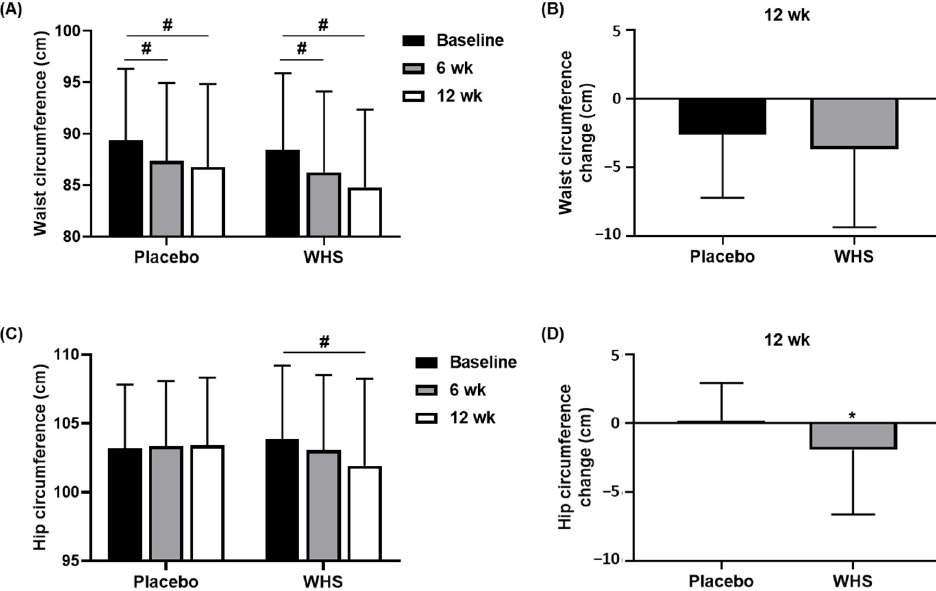
Figure 5. Changes in waist and hip circumferences. Changes in ( A , B ) waist circumference and ( C , D ) hip circumference were measured in placebo- and WHS-treated groups at baseline, 6, and 12 weeks. Values are present as mean ± SD; # p < 0.05 derived from paired t -test within groups (Weeks 0 vs. 6 or 12), and * p < 0.05 derived from a two-sample t -test or Wilcoxon rank-sum test between groups (Placebo ( n = 45) vs. WHS ( n =